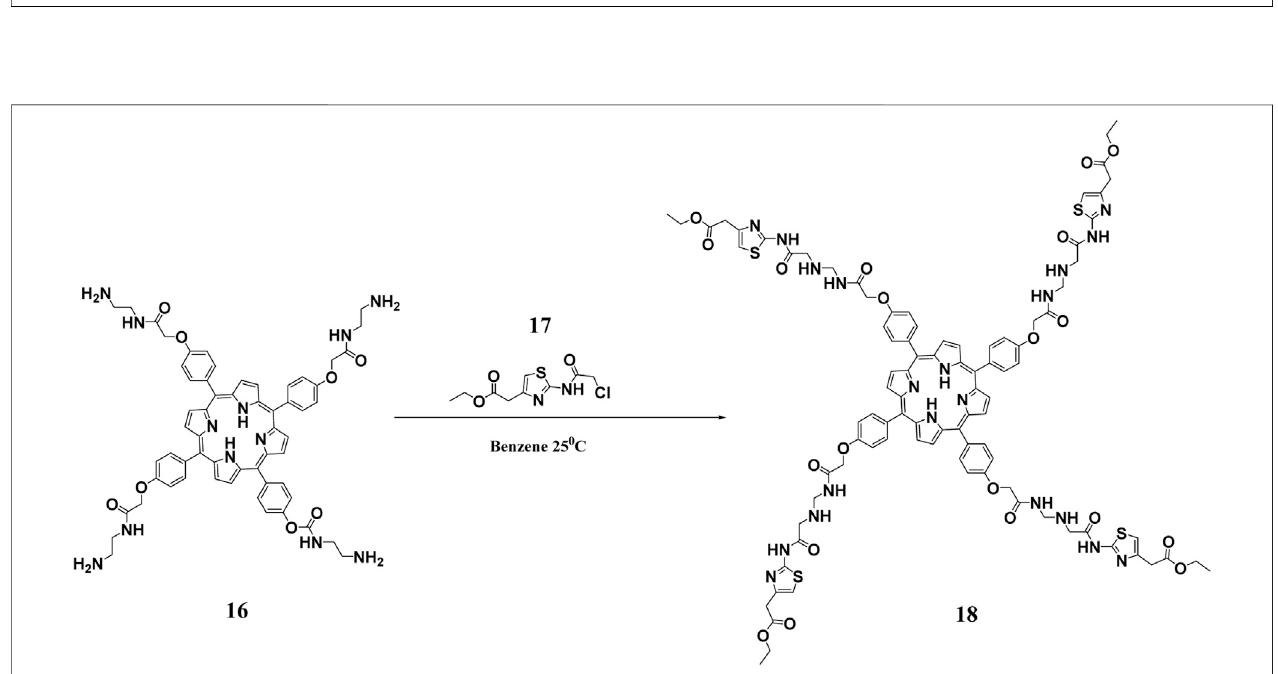
FIGURE 6 | Synthesis of hydrophilic DPs. This scheme shows the reaction of a polyamidoamine (PAMAM) functionalized porphyrin with ethyl 2-(2- chloroacetamido)-4-thiazoleacetate to obtain the hydrophylic DP. Reproduced with permission from Hernández Ramírez et al. (2020).